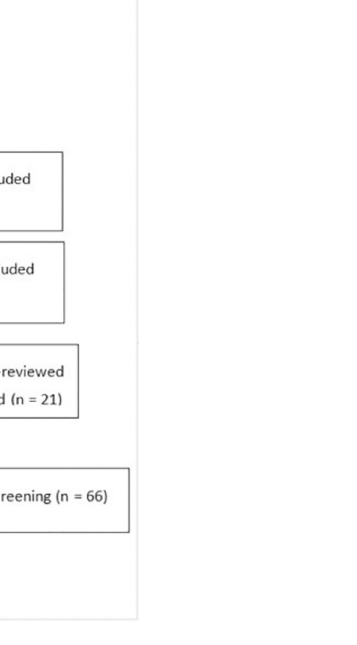
Fig 1. Inclusion and exclusion flow